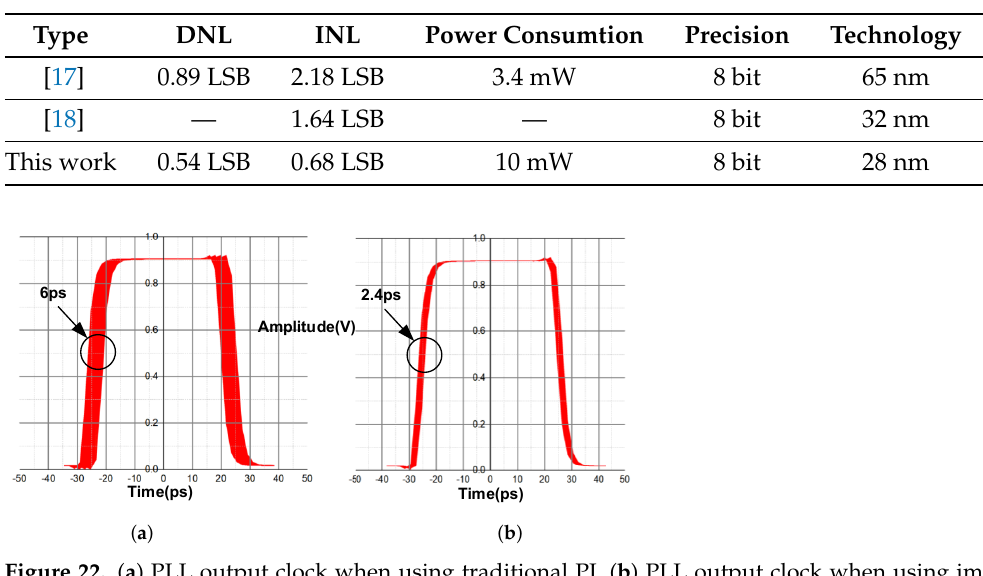
Table 3. Comparison for PI.